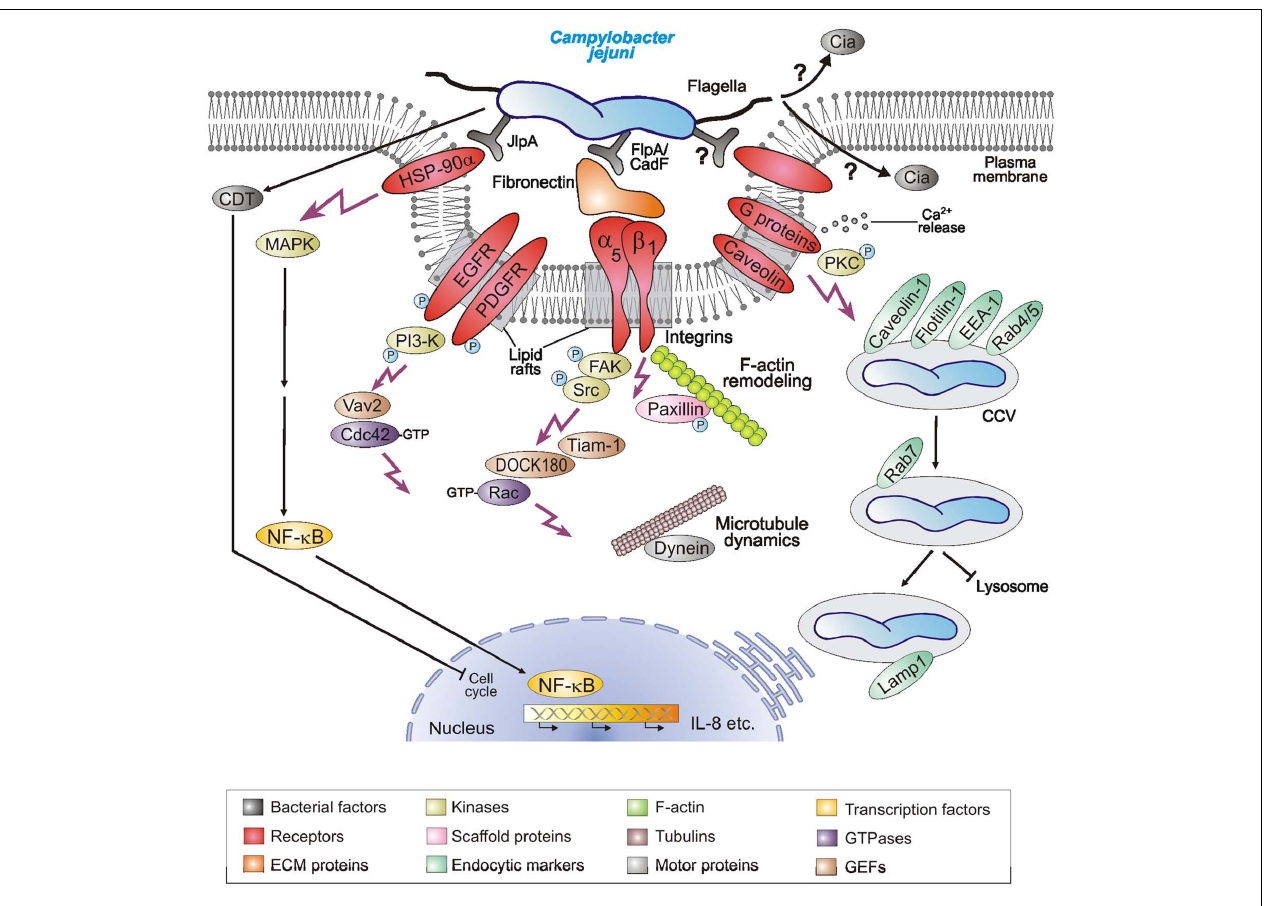
rearrangements at the site of C. jejuni entry, resulting in engulfment and bacterial uptake. Several indicated host cell signaling molecules and pathways including the intracellular survival in Campylobacter- containing vacuoles (CCVs) have been reported in in vitro infection models and may play a role during pathogenesis in vivo . For more details, see tables and